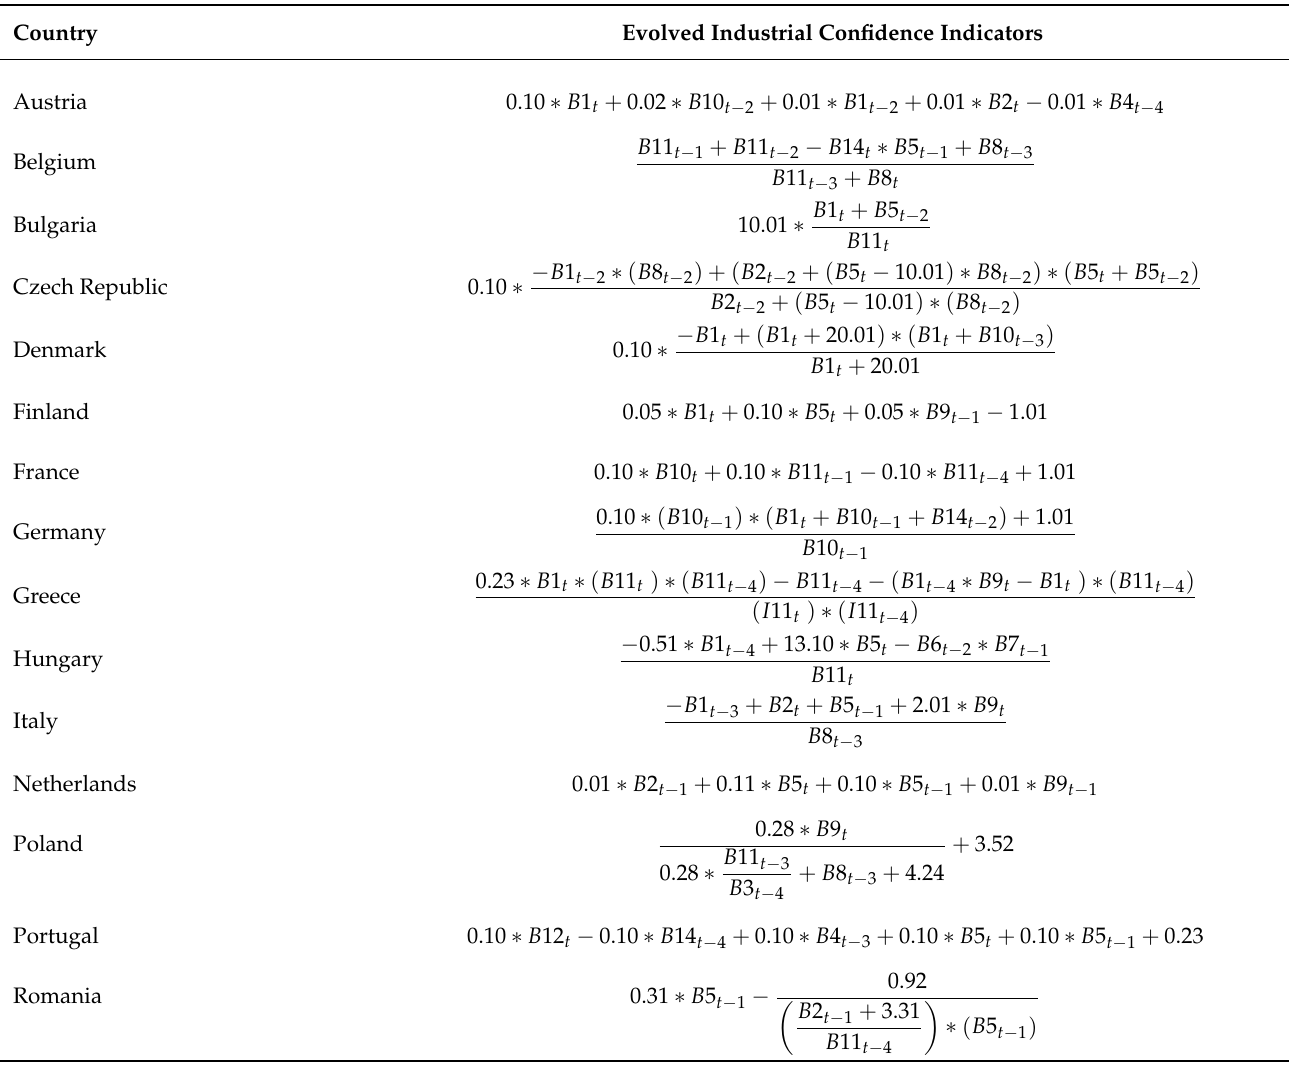
Table 1. Evolved industrial confidence